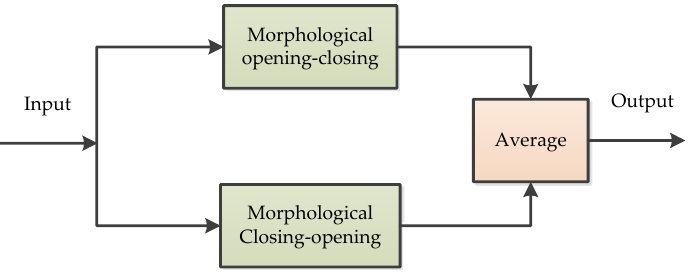
Figure 4. The principle of morphological filter.